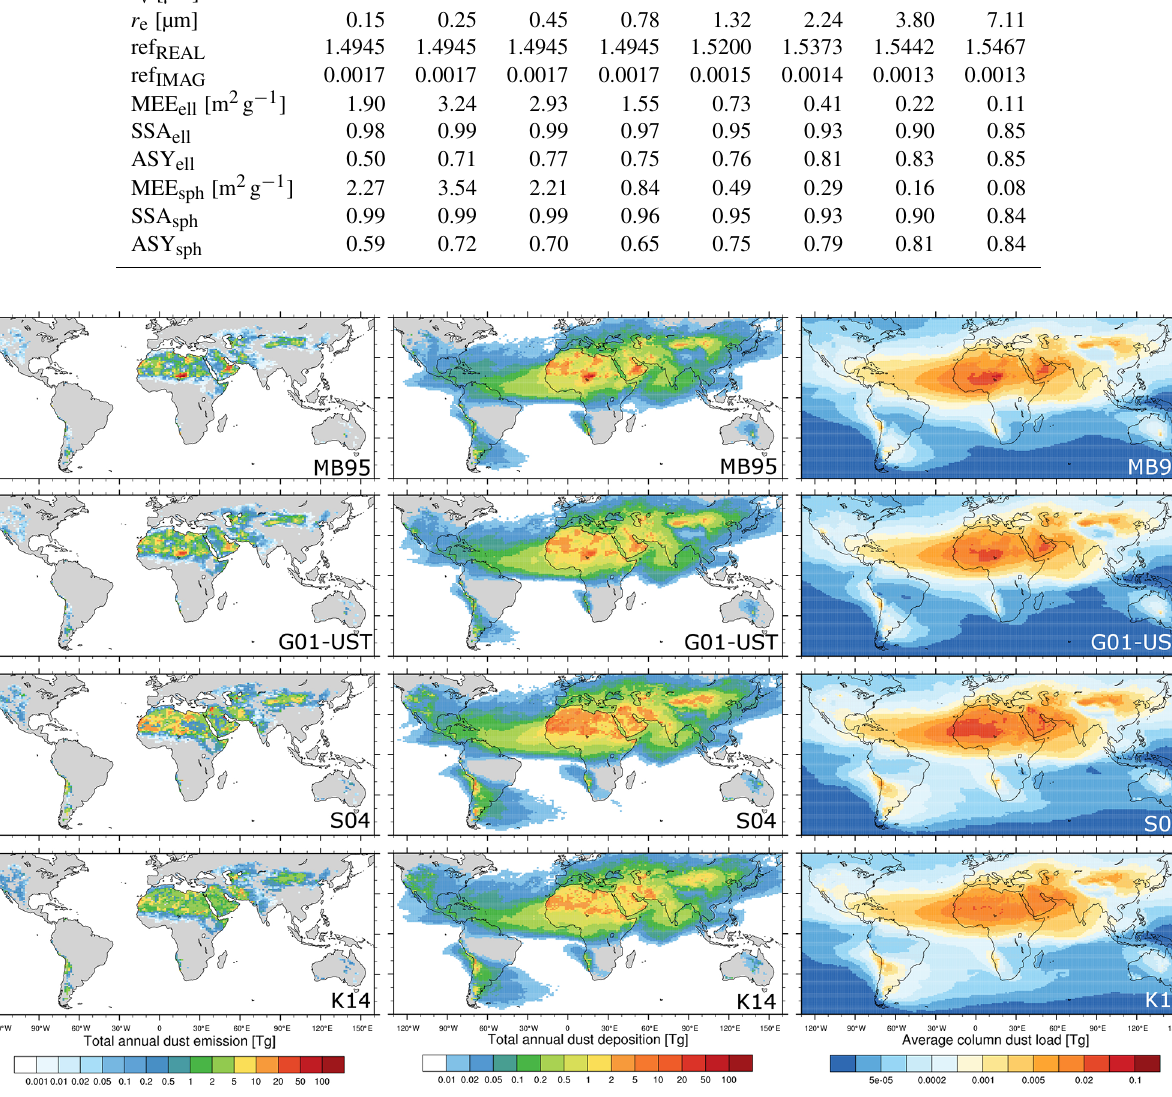
Figure 4. Total annual dust emission (left), dust deposition (center), and annual average column dust load for 2012 using the configurations described in Sect. 4.1. Dust deposition includes gravitational settling, turbulent diffusion, and wet deposition from convective and non- convective precipitation. Shown are results for dust-particle diameters up to